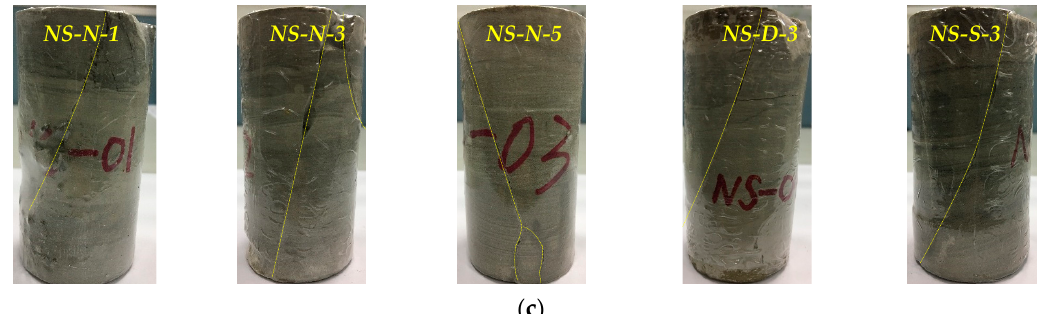
Figure 4. Failure modes of all specimens. ( a ) Mudstone, ( b ) sandstone, ( c ) sandy mudstone.